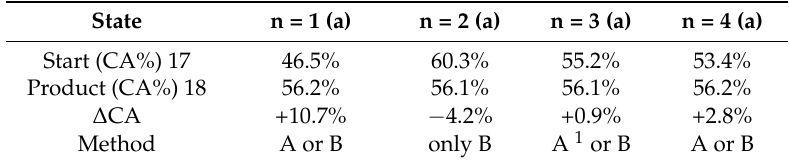
Table 1. The calculated carbonylicity values (CA%) of compounds 17a – d and 18a – b and the carbonylicity changes ( ∆ CA) for ring-opening alcoholysis depending on the ring